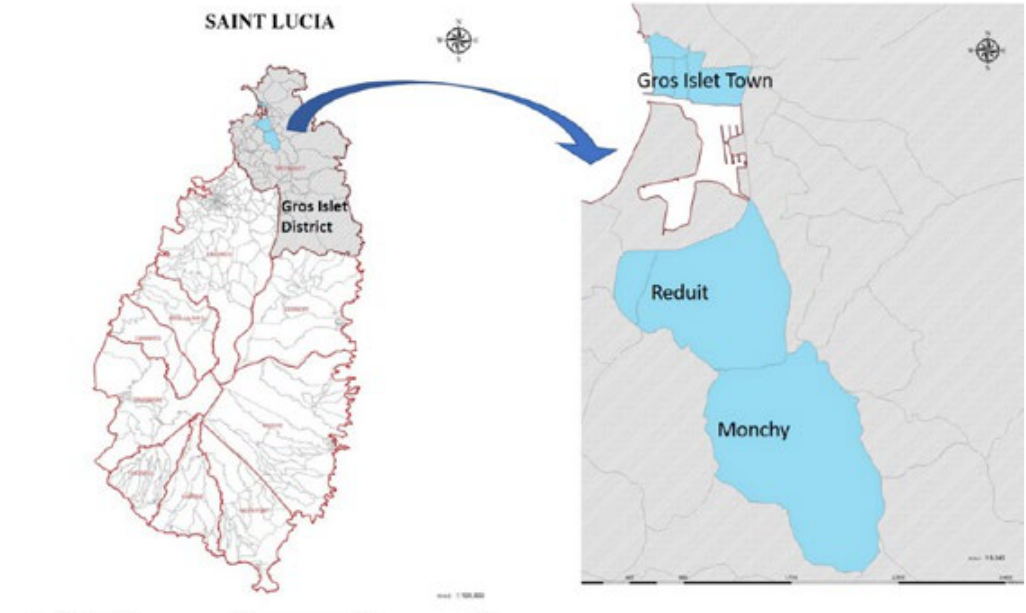
Fig. 1: Geographic location of the study area in district of Gros Islet in the island of Saint Lucia